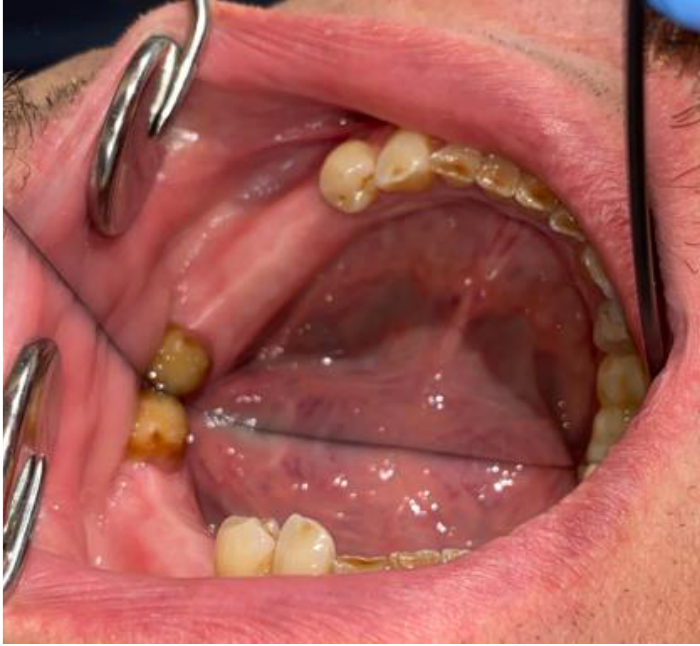
Figure 7. Visible scope of missing teeth scheduled for dental implant placement.